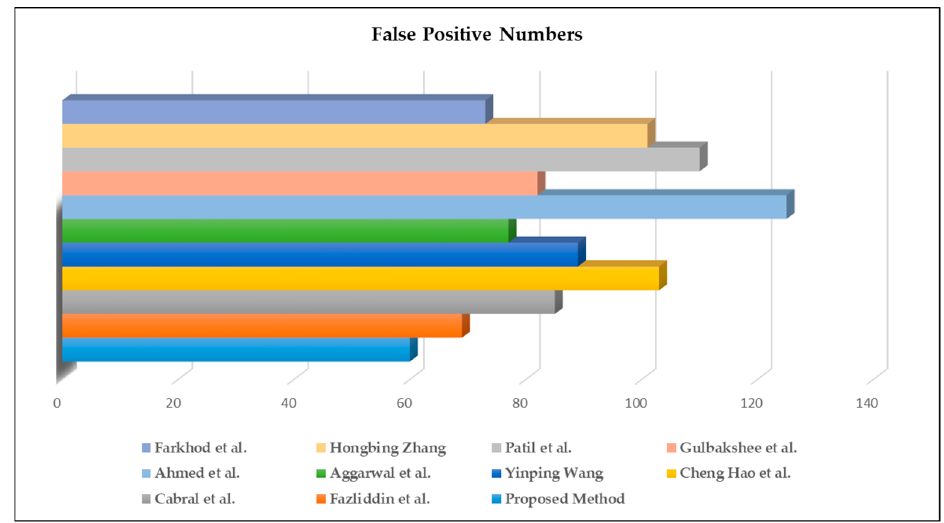
Figure 12. Visible results of false-positive speech signal feature extraction experiments.